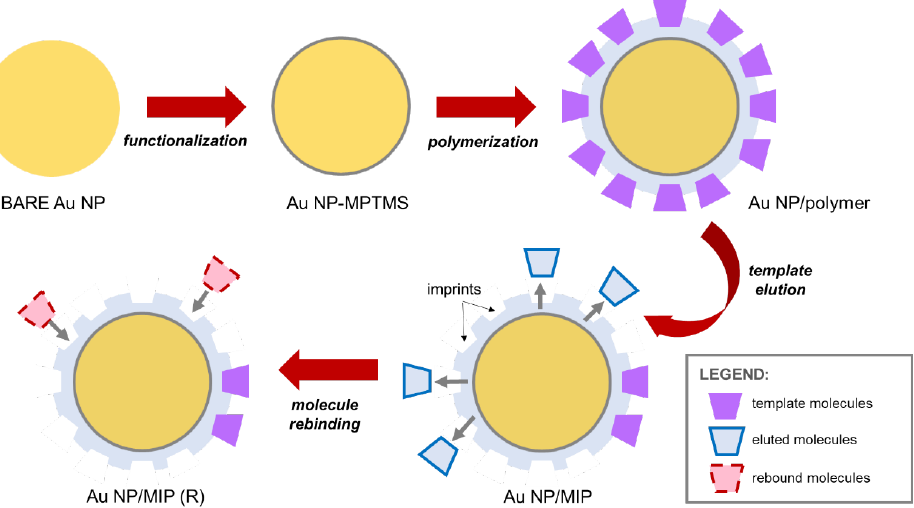
Figure 5. Schematic diagram of the stepwise procedures in the fabrication of Au NP / MIPs—Au NP functionalization with MPTMS followed by polymerization together with template molecules and subsequently, template elution to form molecular imprints wherein rebound molecules would enter during the detection process.